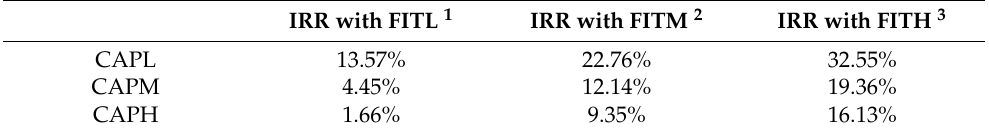
Table 6. Internal rate of return (IRR) based on three quoted capital expenditure levels (supplier quotes obtained for the site under study), electricity production only (CHP-E scenario).